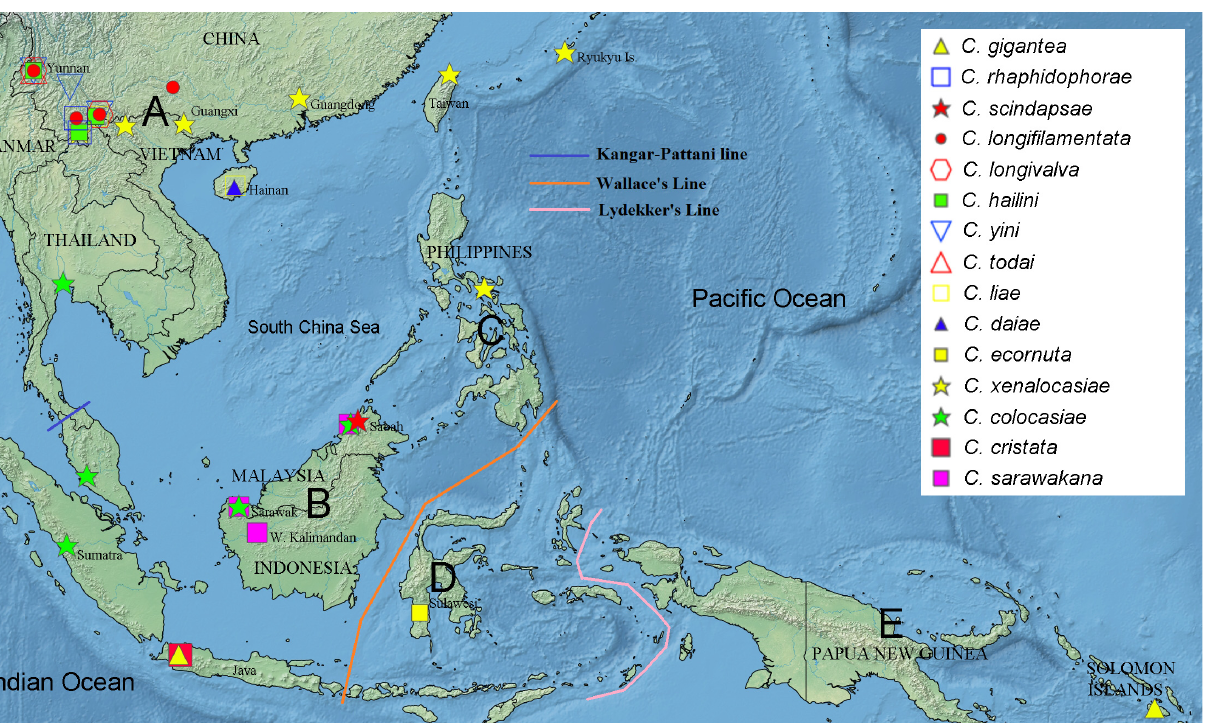
Table 2. Statuses of the distribution areas, host plant uses and body sizes of ten species in the Colo- casiomyia gigantea group and five representative species from the C. cristata group. Species Group Species Geographical Distribution a Host Use b Body Size c